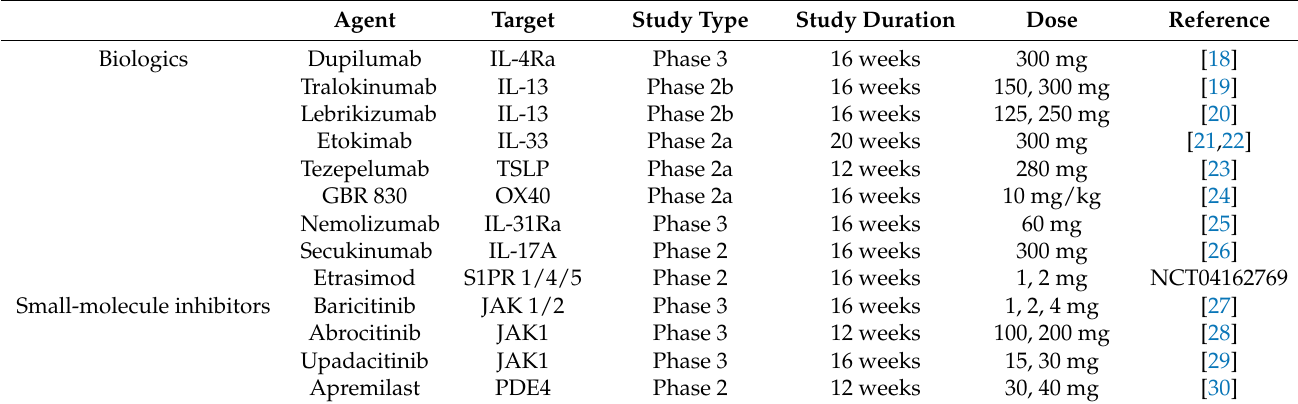
Table 1. Emerging Systemic Agents.